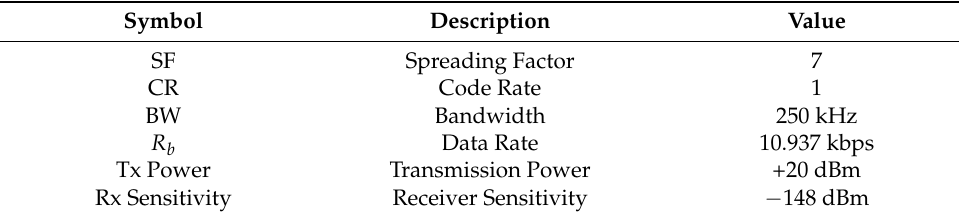
Table 3. LoRa parameters.